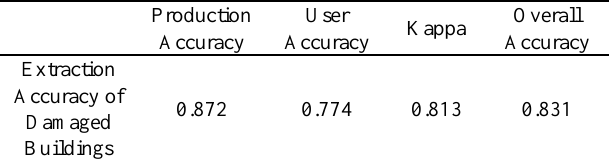
Figure 6 Classification decision